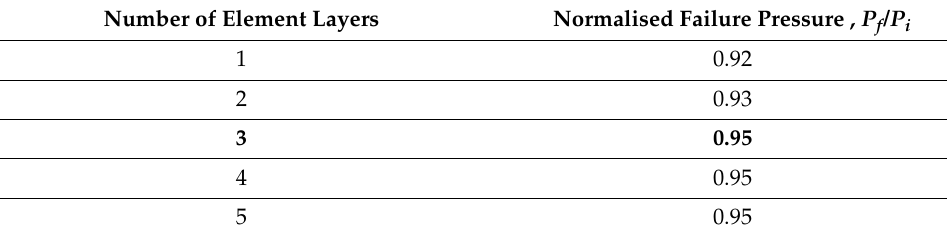
Figure 3. Quarter pipe model of a pipe with circumferentially aligned interacting corrosion defects. Table 5. Convergence test details and